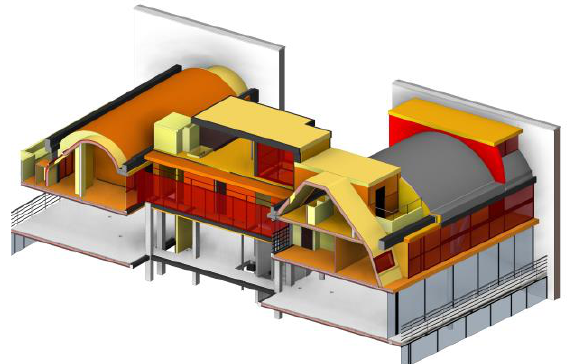
Figure 12 Numerical model with thermal heat loss represent with a scale of red